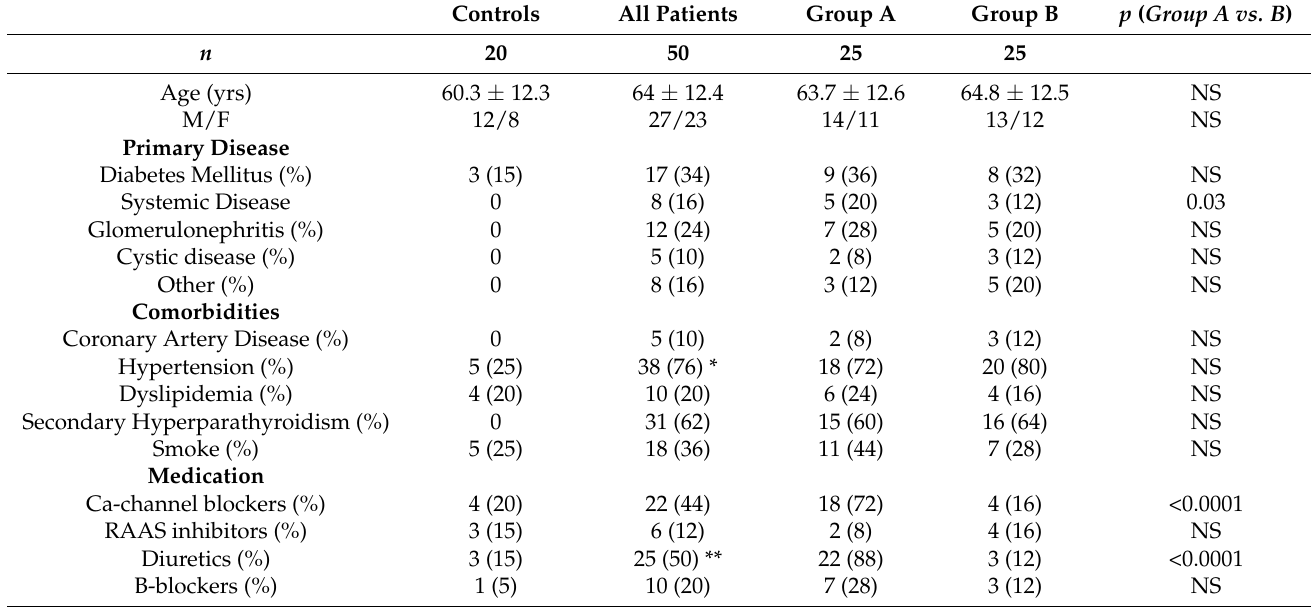
Table 1. Clinical characteristics of patients and controls. Differences between group A (pre-HD), group B (HD) patients. Controls All Patients